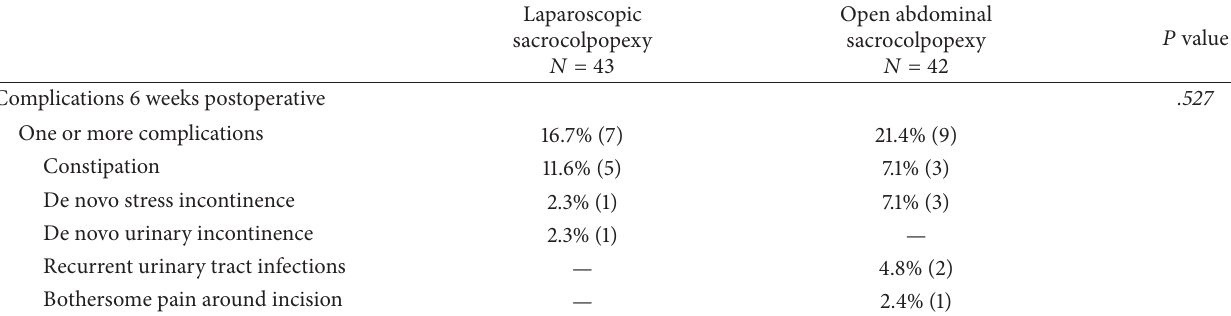
Table 5: Patients with complications 6 weeks postoperative